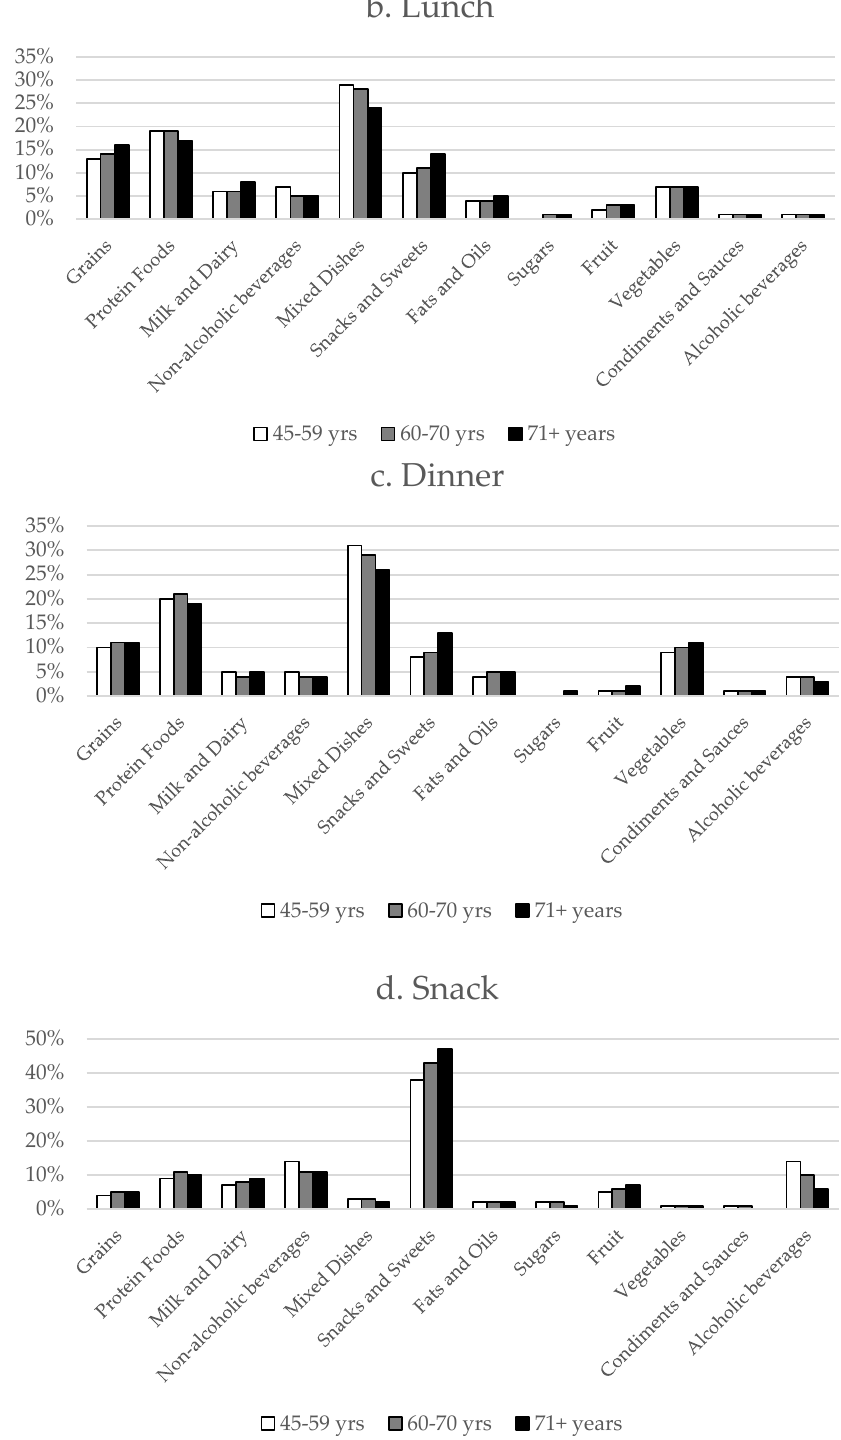
Figure 1. Percent of energy from food sources based on the US Department of Agriculture What We Eat in America food categories during meals and snack occasions by age categories during ( a ) breakfast, ( b ) lunch, ( c ) dinner, and ( d ) snacks.